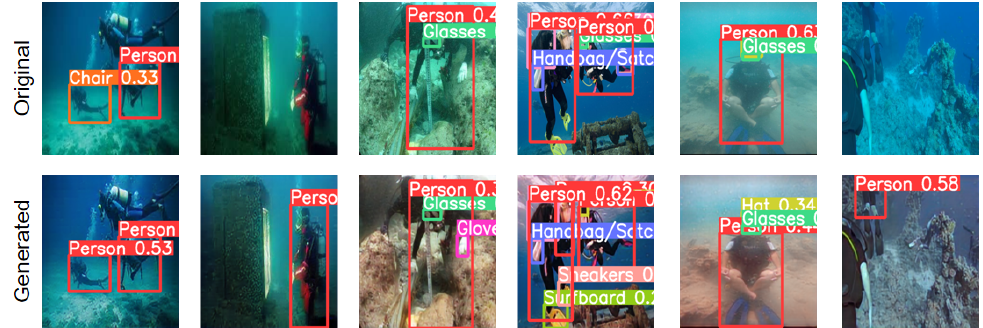
Figure 12. Object detection results on EUVP